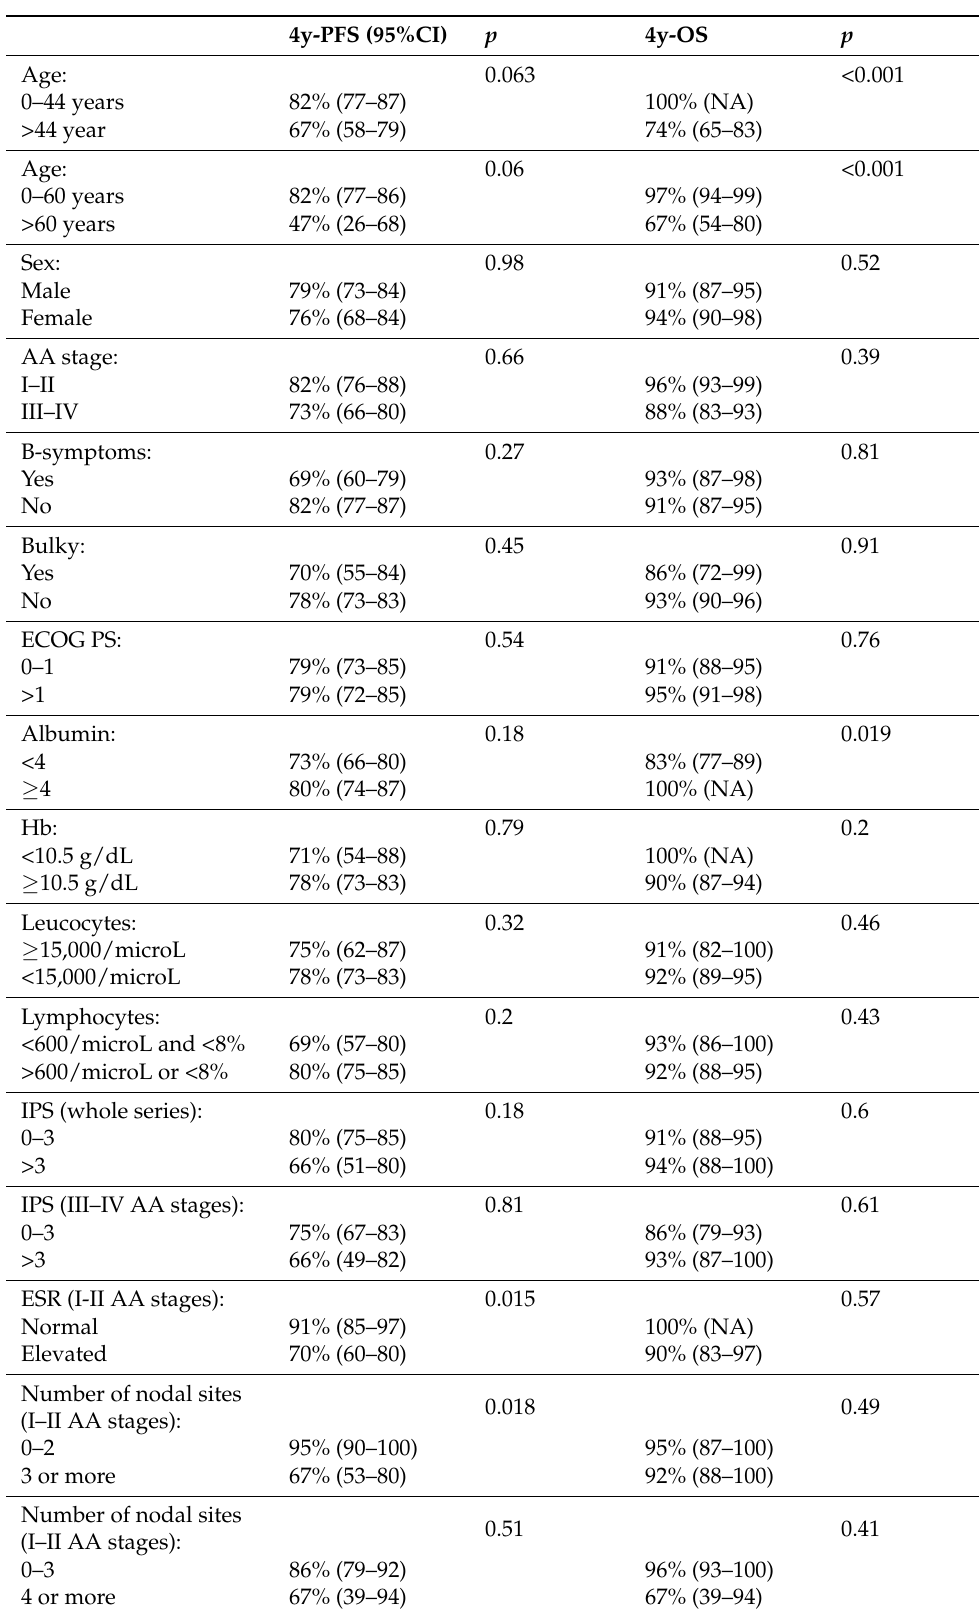
Table 2. Survival analysis according to main standard prognostic variables in